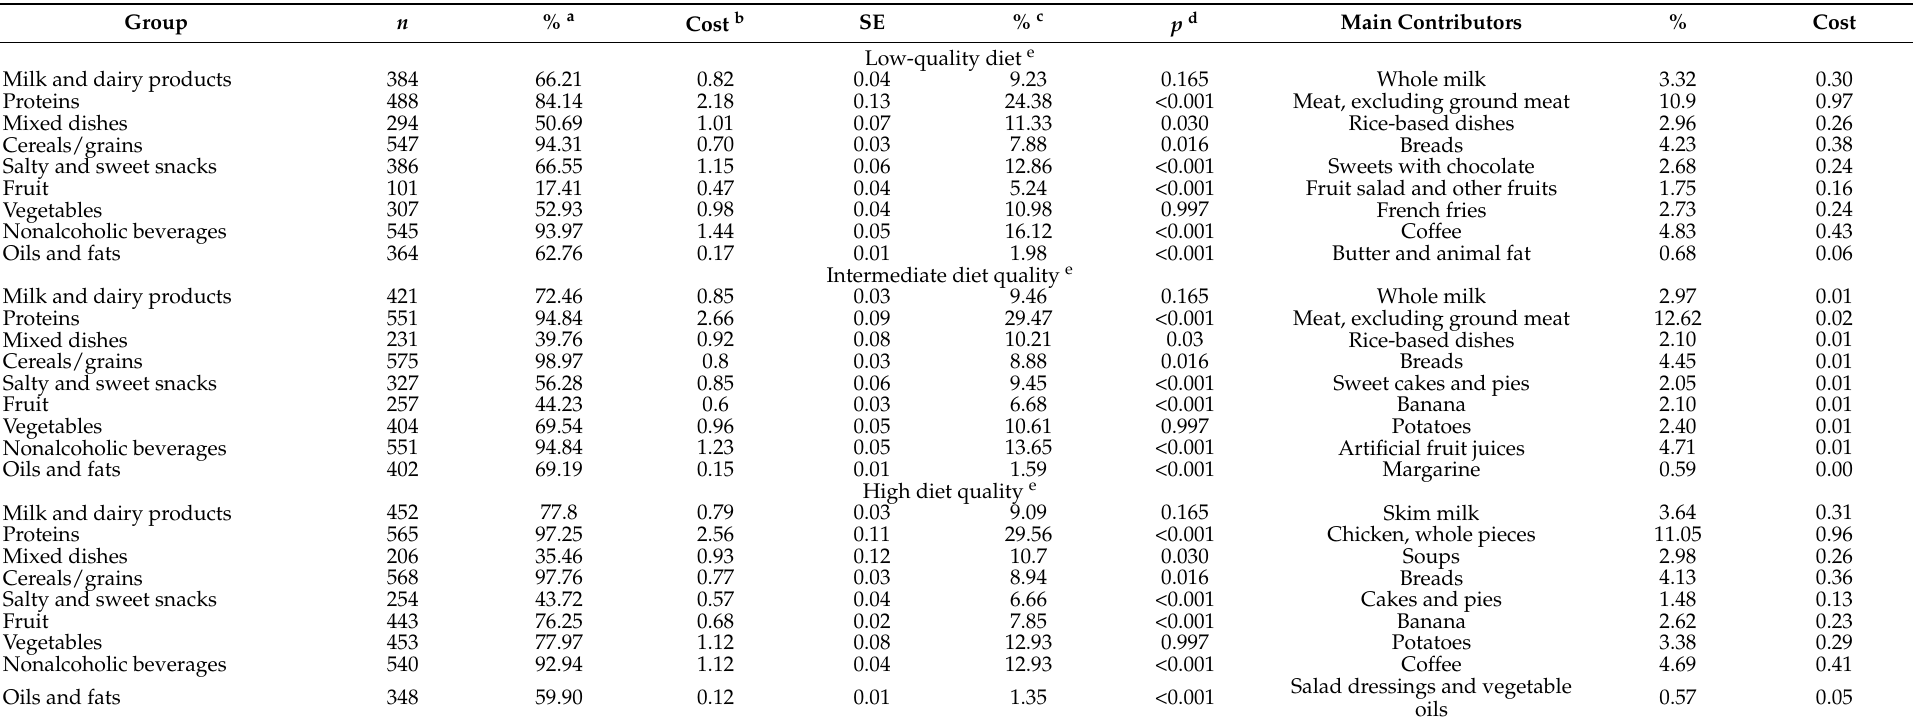
Table 4. Proportion of consumers, daily cost, and main contributing group, according to WWEIA classification and diet quality, adapted for Latin America. ISA-2015, Sao Paulo,